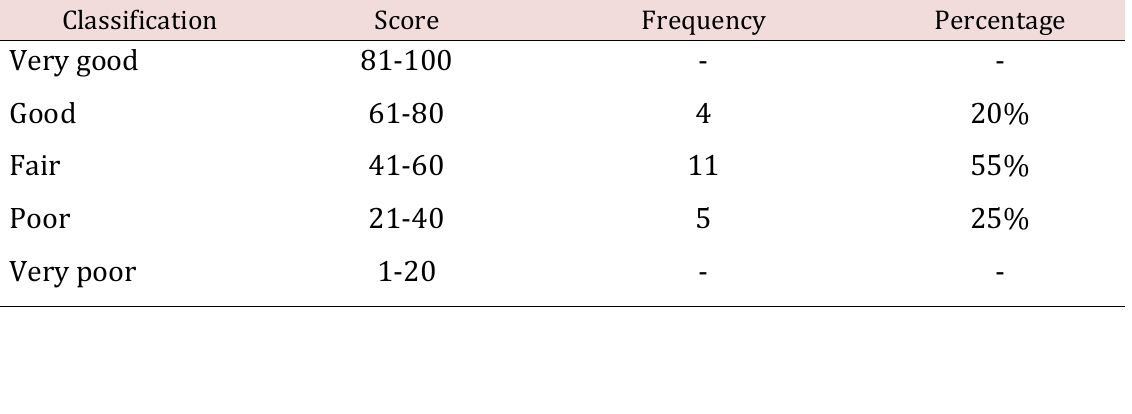
Table 3. The rating percentage of students' in cycle 1 Classification Score Frequency